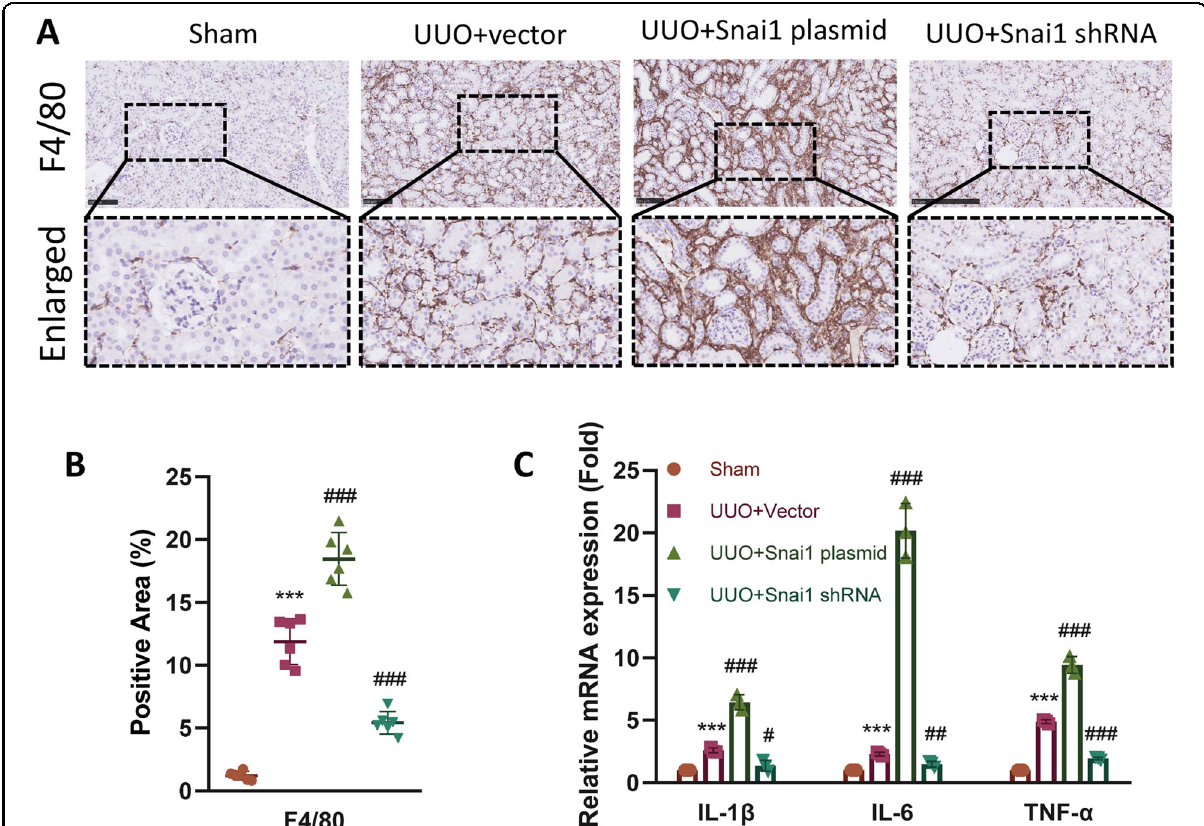
Fig. 5 Regulation of Snai1 expression changes renal in fl ammation. A Immunohistochemistry staining and enlarged images of F4/80-positive macrophages in the interstitium of sham, UUO + vector, UUO + Snai1 plasmid, and UUO + Snai1 shRNA group and B their quanti fi cations. Scale bar = 100 μ m. C Relative mRNA expression of IL-1 β , IL-6, and TNF- α in kidneys from different groups. *** P < 0.001 compared with the sham group. # P < 0.05; ## P < 0.01; ### P < 0.001 compared with the UUO + vector